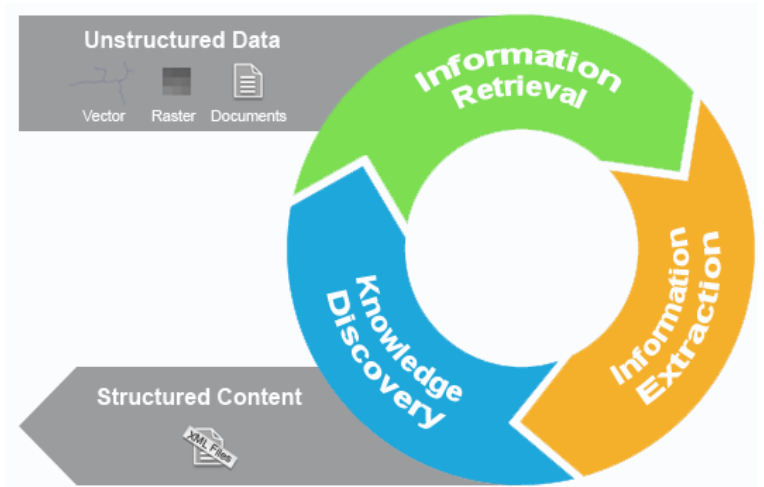
Figure 5. Data-knowledge